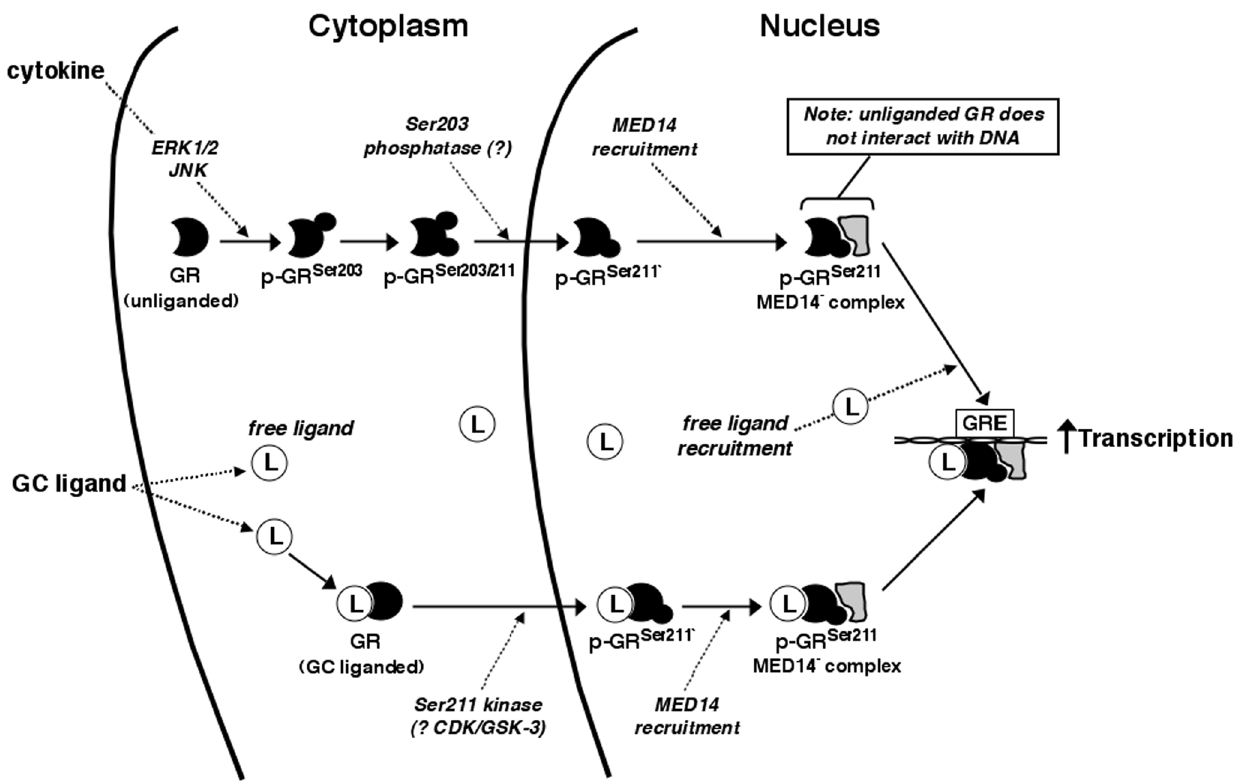
Figure 8. Schematic representation of proposed homeostatic mechanism involving cytokine-stimulated ligand-independent GR activation and its induction of heightened ligand-stimulated GR signaling and transactivation. Cytokine (IL-13) exposure acutely elicits ERK1/2- and JNK-mediated GR Ser203 phosphorylation that leads to p-GR Ser203 -dependent GR Ser211 phosphorylation. The dual GR Ser203/211 phosphorylated state is transient, as Ser203 becomes dephosphorylated (unidentified phosphatase (13)) and p-GR Ser211 translocates to the nucleus where it associates with the transcriptional co-factor, MED14. In the absence of hormone, the unliganded p-GR Ser211 -MED14 complex is incapable of binding to DNA. With hormone exposure, ligand entering the cell can translocate to the nucleus both as free and GR-bound ligand, the latter leading to GR Ser211 phosphorylation potentially via the kinase activities of cyclin-dependent kinase (CDK) or glycogen synthase kinase-3 (GSK-3). Note: relative to ligand treatment alone, combined cytokine + ligand exposure elicits increased intra-nuclear levels of p-GR Ser211 coupled to MED14, leading to heightened GR transcriptional activity upon recruitment of free ligand to the cytokine-stimulated unliganded p-GR Ser211 -MED14 complex.